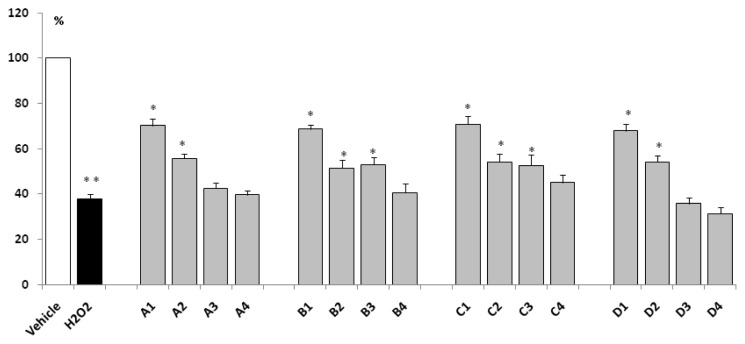
MTT analysis of PC12 cell viability after different treatments: Vehicle (H2O or DMSO), H2O2 (hydrogen peroxide, 200 μmol/L), A ((+/−)-thioctic acid), B ((+)-thioctic acid, piperazine salt), C ((+)-thioctic acid, lysine salt), and D ((−)-thioctic acid). The Arabic numbers (1, 2, 3 and 4) close to the letters represent the different concentrations (100, 50, 20 and 10 μmol/L, respectively) for every treatment. The data were expressed as the percentage of viable cells and were the mean of ± SE of three different experiments. ** p < 0.05 vs. vehicle alone ; * p < 0.05 vs. H2O2 only.